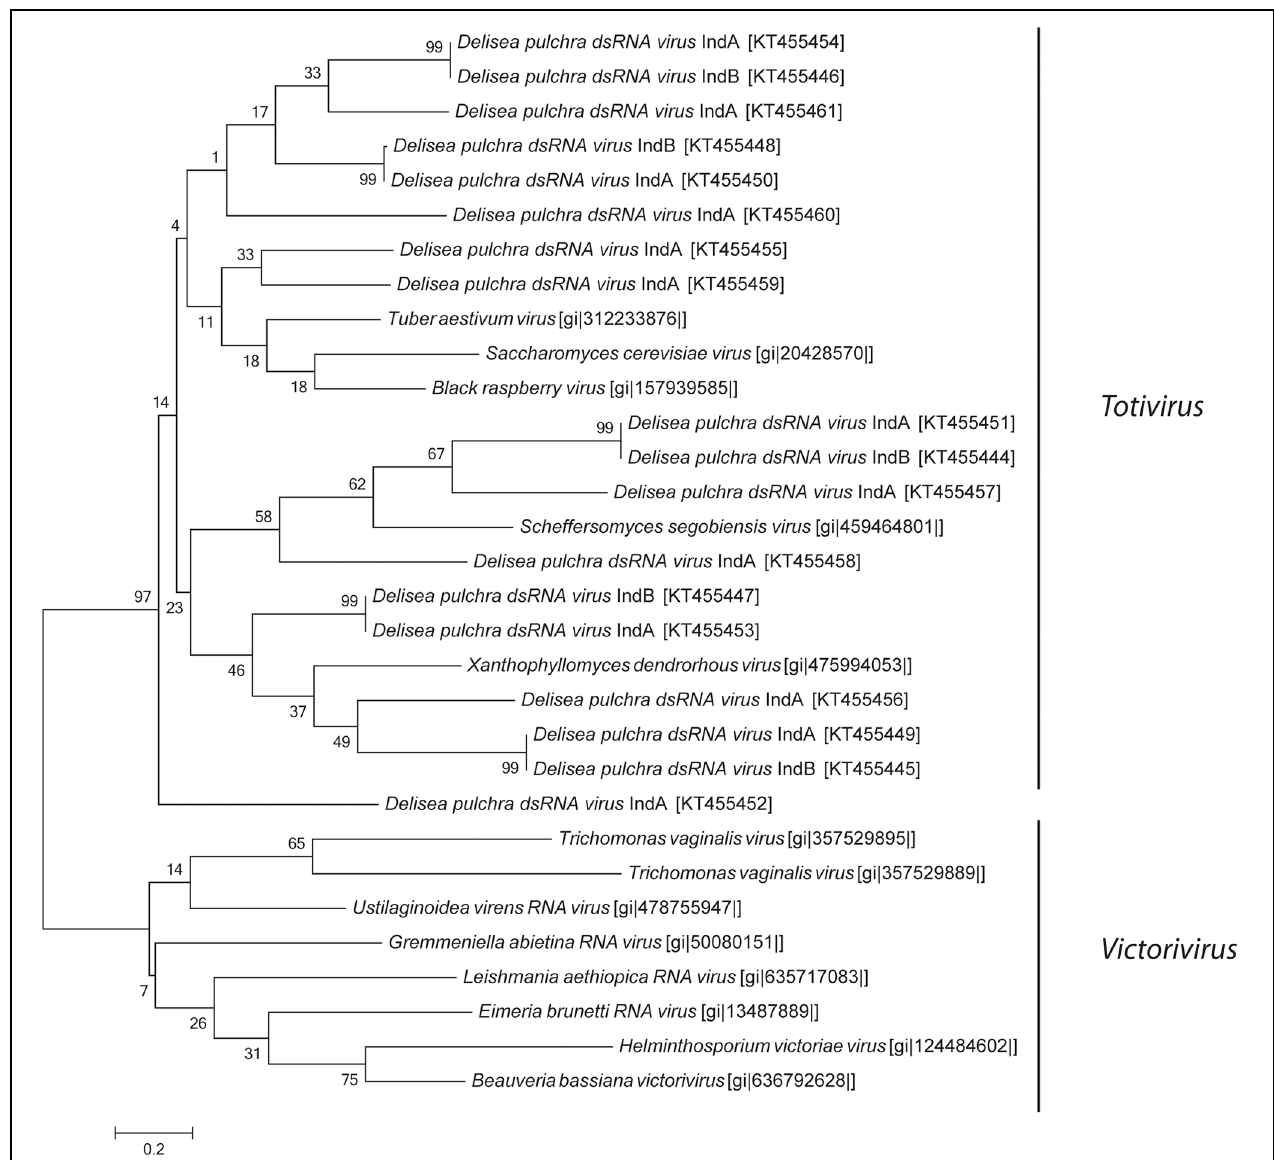
FIGURE 5 | Maximum-likelihood phylogenetic tree of D. pulchra associated Totiviridae based on the RdRp amino acid sequence compared to the genus Victorivirus and Totivirus . NCBI accession numbers are shown in brackets. The scale bar represents 20% of amino acid changes between close